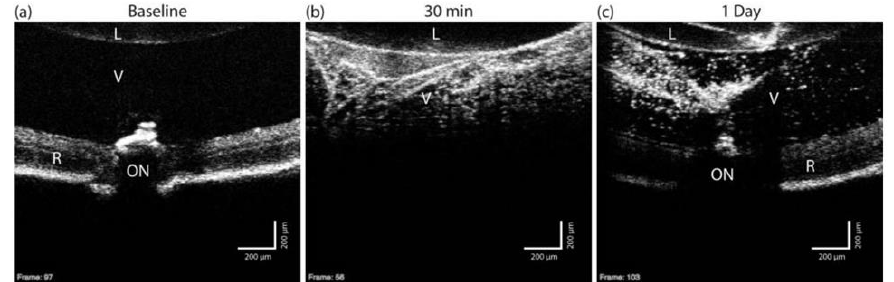
Figure 6. Single cross-section OCT images ( a – c ) of a single living mouse, before and after PSS–AuNR injection in the vitreous. Signal increase is to be noted. However, 30 min after the injection, the imaging of retina is unclear. The lens (L), the optic nerve (ON), the retina (R), and the vitreous (V) are visible in the images [92]. Copyright © 2012, BMJ Publishing Group Ltd. All rights reserved. Br J Ophthalmol. Author manuscript; available in PMC 22 Jul 2013. Published in final edited form as: Br J Ophthalmol. Dec 2012; 96(12): 1522 – 1529. Published online 19 Oct 2012. doi:10.1136/bjophthalmol-